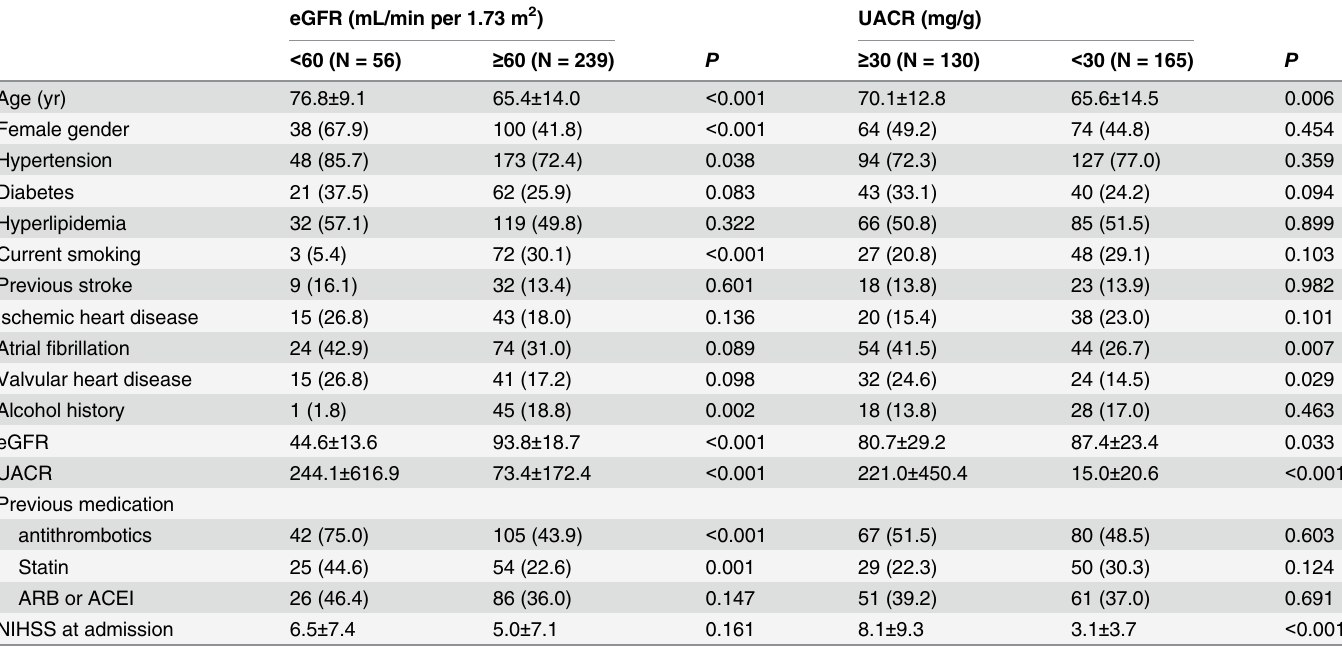
Table 1. General characteristics of the 295 study patients with and without renal dysfunction; mean ± SD, number